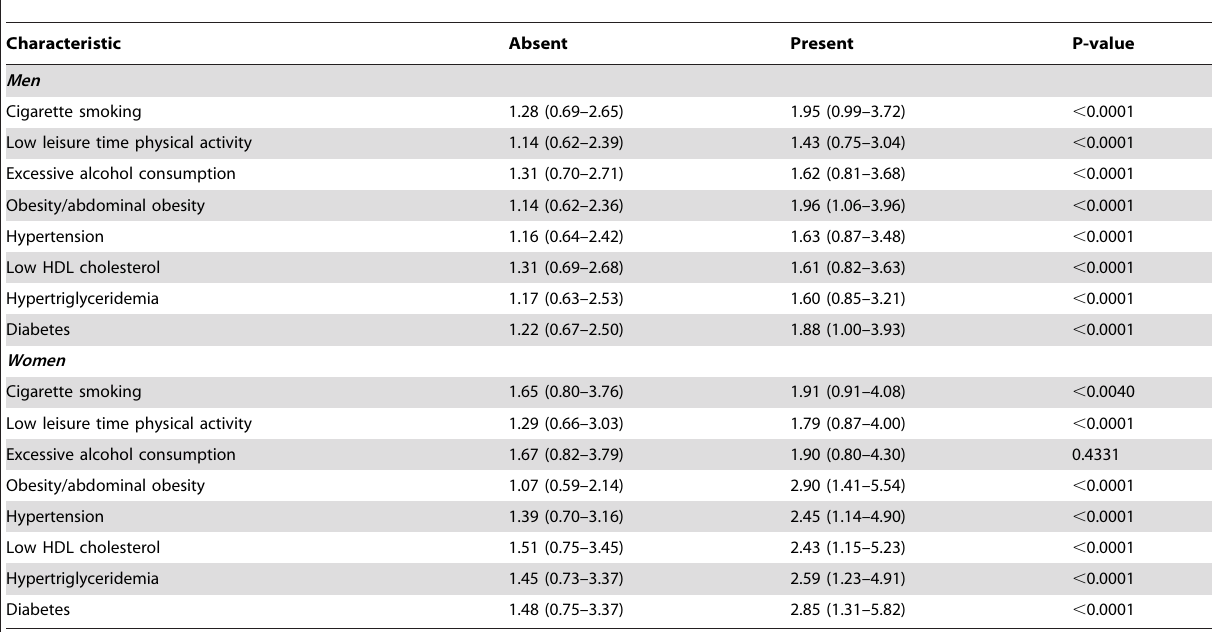
Table 3. Median CRP Levels (interquartile range) according to the presence or absence of health-risk behavior and metabolic alterations among men and women.